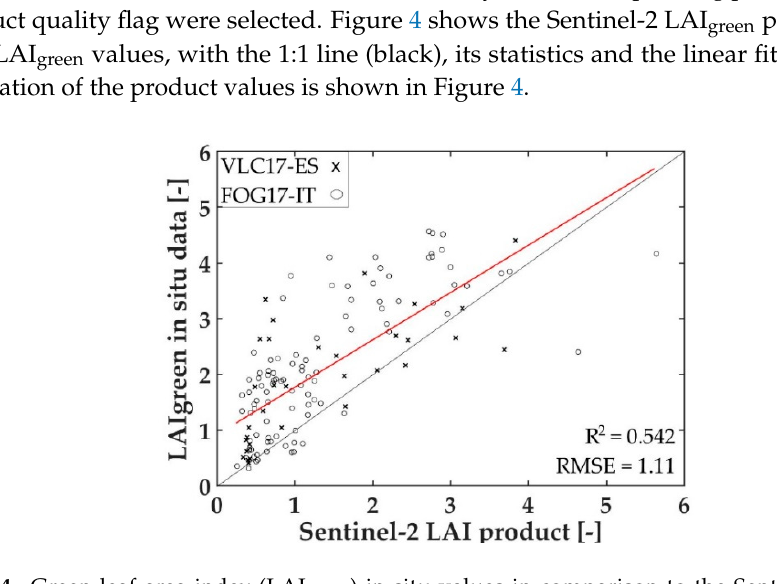
Figure 4. Green leaf area index (LAI green ) in situ values in comparison to the Sentinel-2 LAI green product, with 1:1 line (black), its statistics and linear fitting (red).